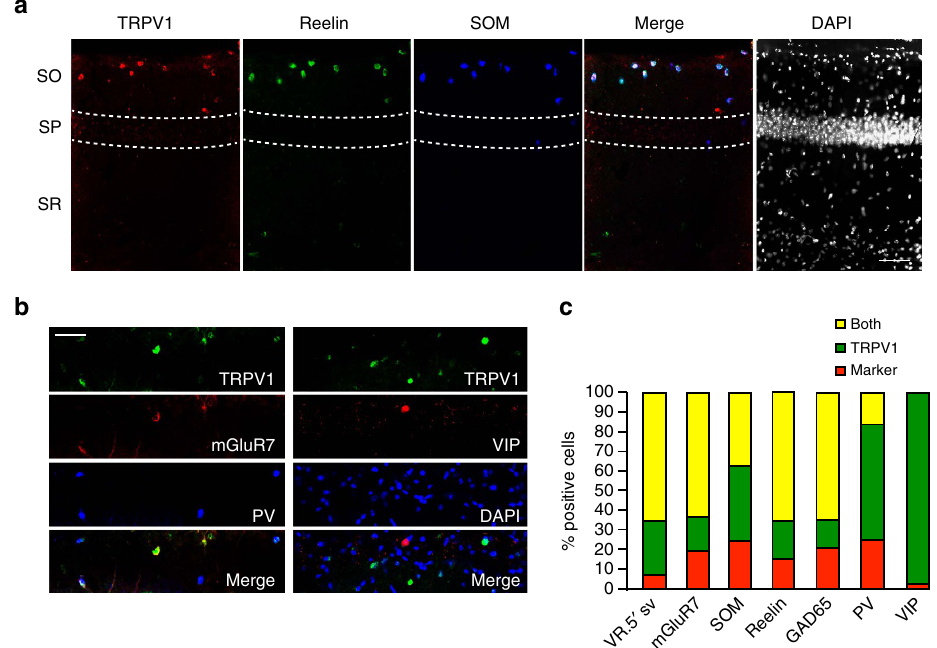
Figure 2 | TRPV1 is expressed in OLM neurons in the hippocampus. ( a ) Immunohistochemistry in hippocampal sections reveals a subset of neurons that express TRPV1, reelin and somatostatin in the stratum oriens; scale bar, 100 m m, SO: stratum oriens, SP: stratum pyramidale, SR: stratum radiatum). ( b ) Immunostains of the stratum oriens in hippocampal sections from PV-Tomato reporter mice for TRPV1 and mGluR7 (left) and from VIP-Tomato reporter mice with TRPV1 and DAPI (right); scale bar, 100 m m. ( c ) Quantitation of co-localization of immunofluorescence signal of different markers with TRPV1 neurons in the stratum oriens of hippocampal sections. VR.5 0 sv quantitation indicates signal from the C-terminal TRPV1 antibody, compared to the N-terminal TRPV1 antibody (Fig. 1g). Number of sections analysed: TRPV1/VR.5 0 sv n ¼ 5, TRPV1/somatostatin n ¼ 3, TRPV1/reelin n ¼ 3, TRPV1/VIP n ¼ 3, TRPV1/PV n ¼ 5, TRPV1/GAD65 n ¼ 3, TRPV1/mGluR7 n ¼ 3.